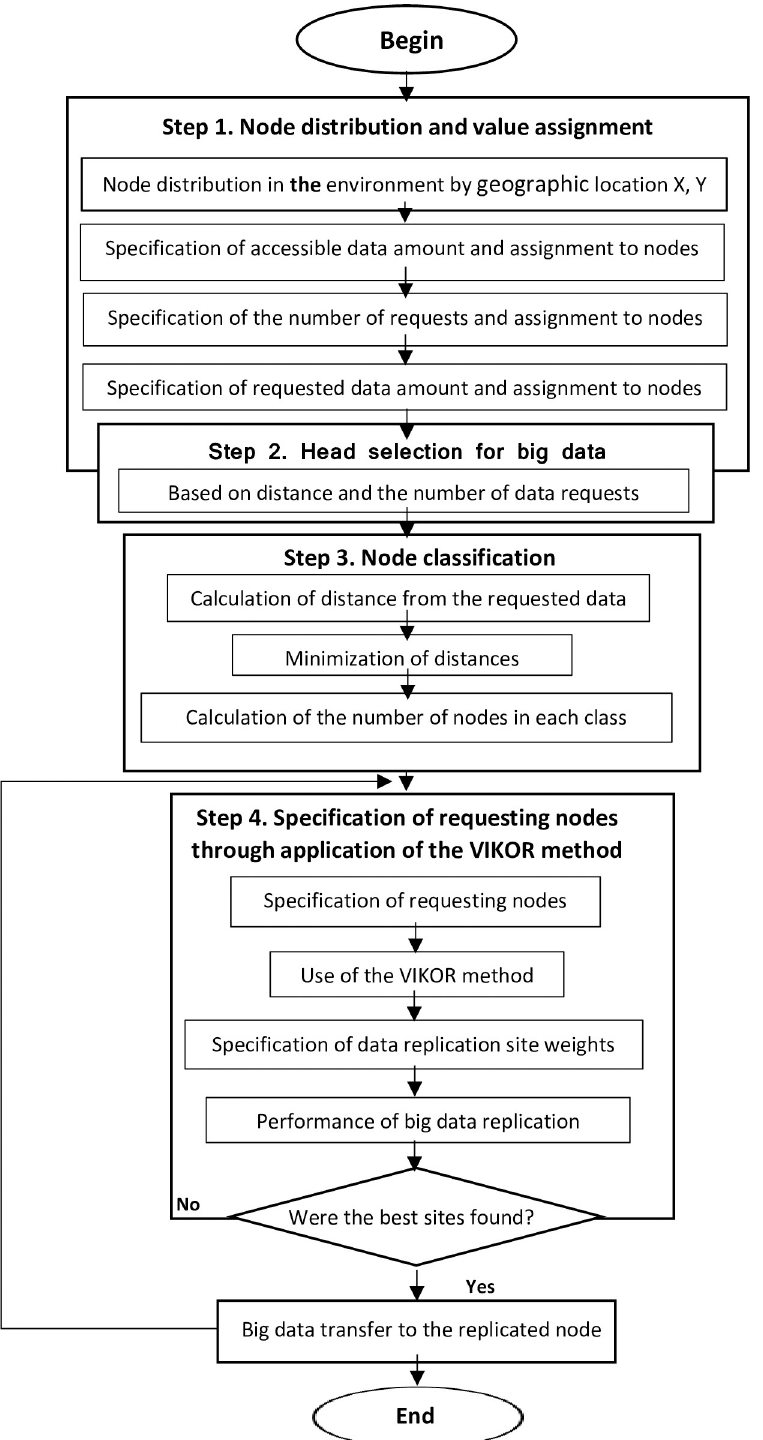
Fig 1. Flowchart of the proposed